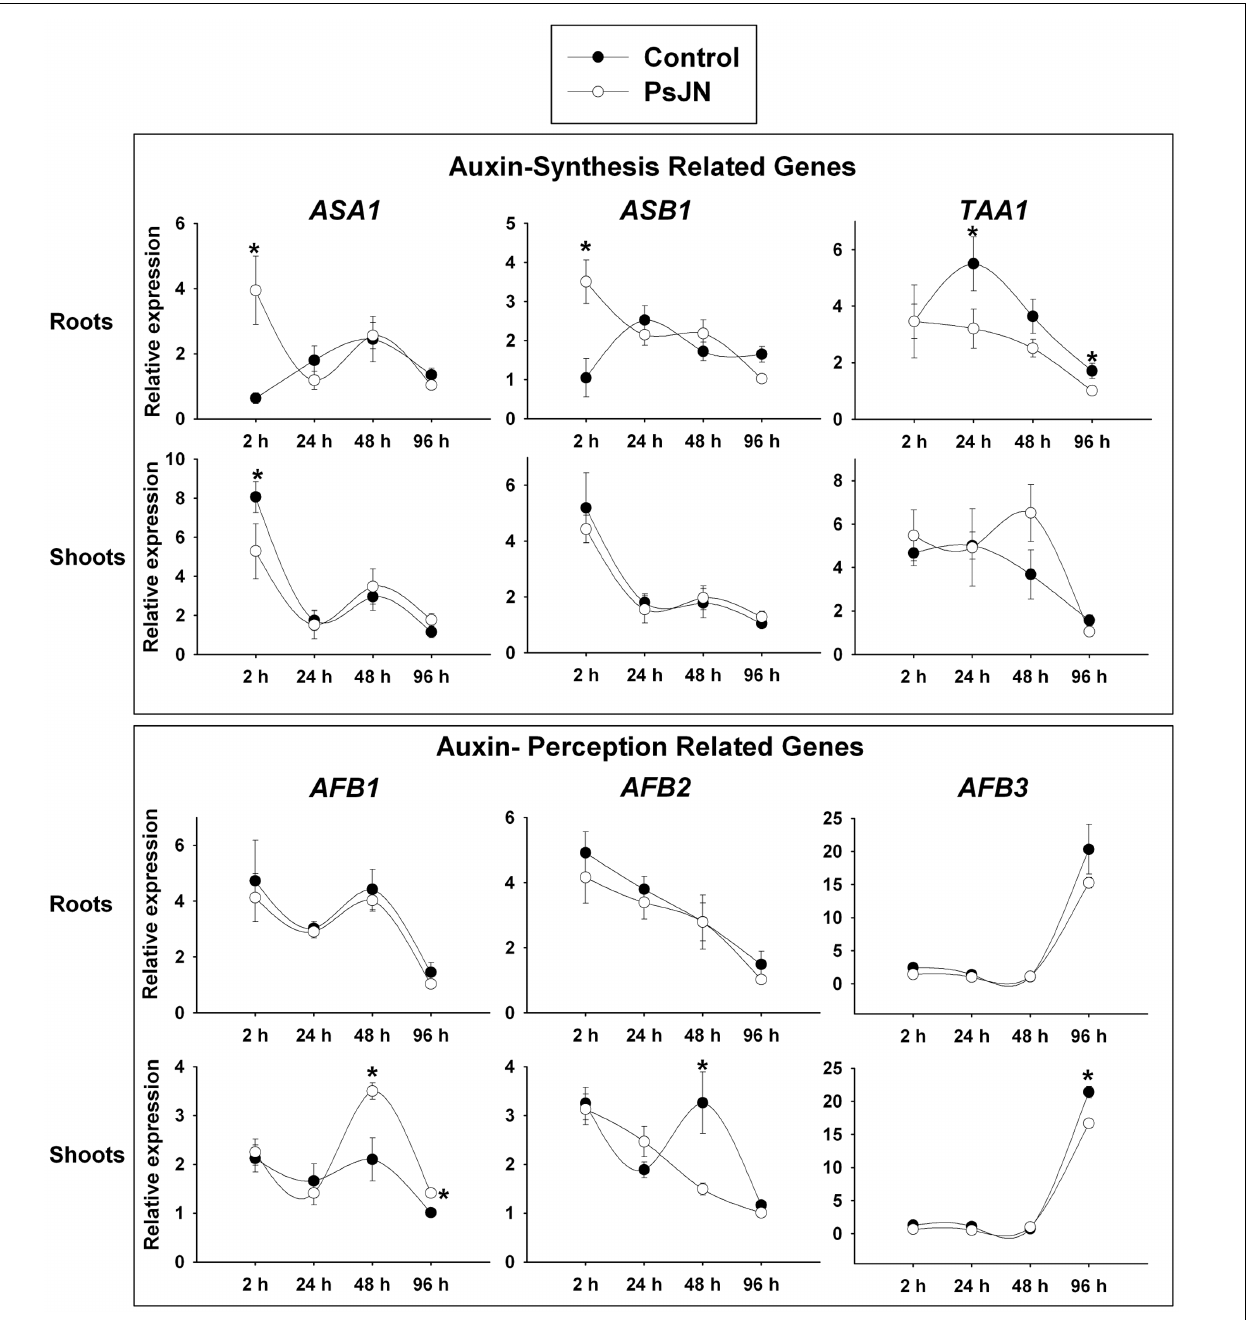
FIGURE 1 | Temporal quantitative real-time PCR of selected Arabidopsis genes involved in auxin synthesis and perception after inoculation with Burkholderia phytofirmans PsJN. Relative gene expression of selected genes involved auxin synthesis and perception in roots and shoots at 2, 24, 48, and 96 h post inoculation (hpi) with the strain. Data are means ± SE of 3–5 biological replicates per treatment, each considering tissue from 5 to 13 plants and two technical replicates. Normalization was performed with the housekeeping SAND family gene (AT2G28390). Asterisk indicates statistical significance among treatments in a particular time (One way ANOVA, p <